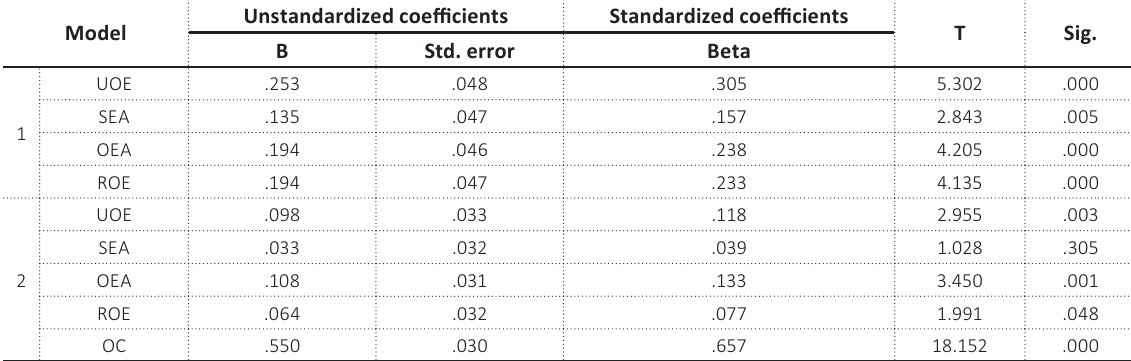
Table 6. Influence of organizational culture on the relationship between emotional intelligence dimensions and job